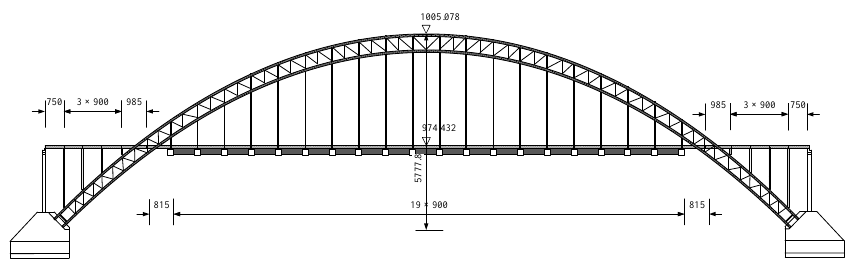
Figure 2. Bridge elevation structure drawing (Unit: cm).